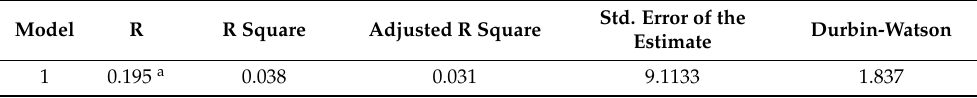
Table 8. OC and the ITG model summary b .